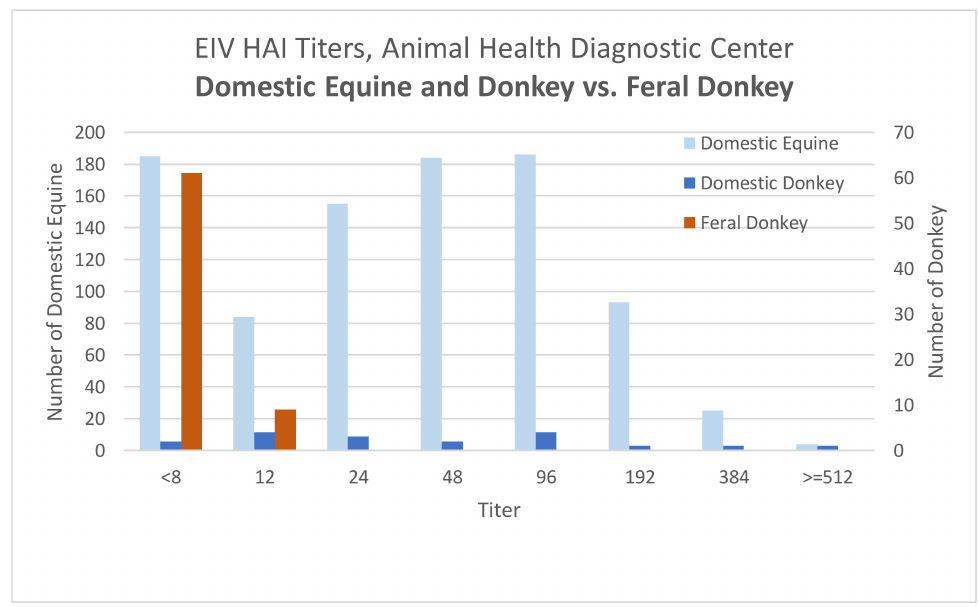
Figure 1. Equine Influenza Virus Hemagglutination Inhibition Titers (EIV HAI). Results for 70 feral donkeys from Death Valley in November and December, 2018, are compared to those obtained for over 900 domestic equines and Equidae (vaccinated and unvaccinated) tested at the AHDC, Cornell University, Ithaca, NY from